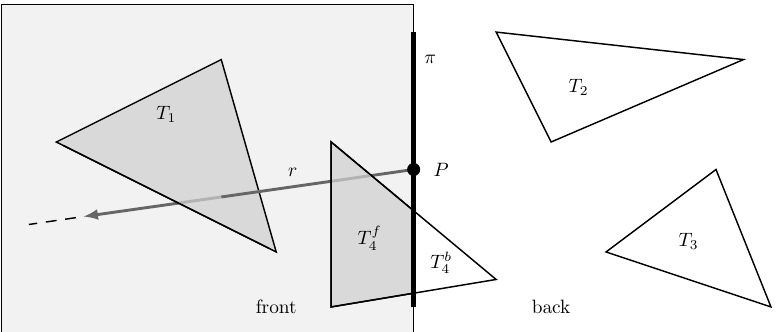
Figure 10. A ray-polygon intersection can be seen as a line-polygon one by considering only front geometries. Notice the case of the polygon T 4 that overlaps the plane π : in this case a clipping procedure is needed to subdivide it in T f and T b 4 4